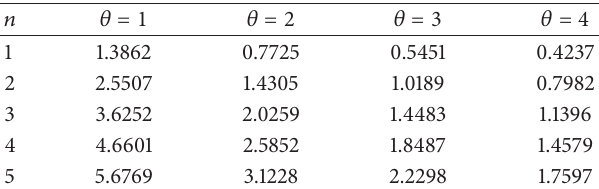
Table 1: Mean of upper records.